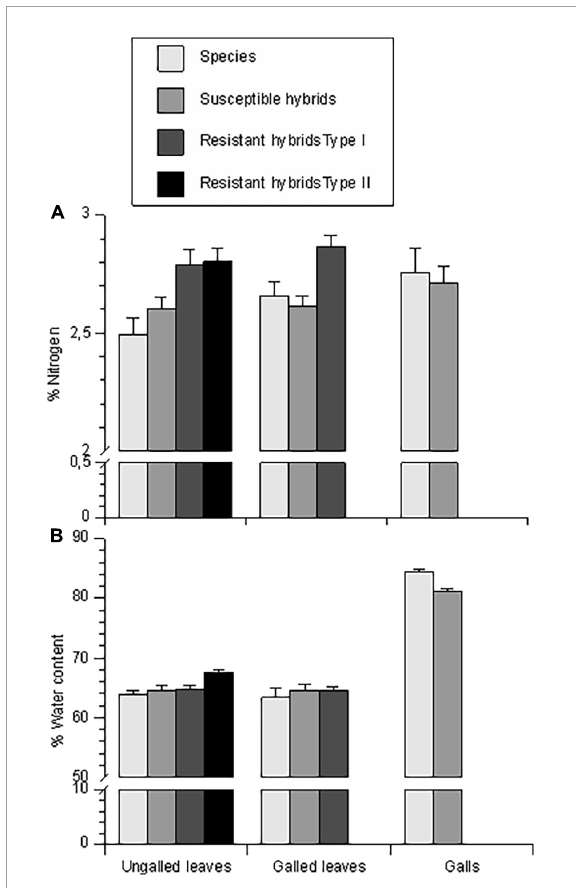
FIGURE8 Foliar concentrations of nitrogen (A) and water (B) in ungalled leaves (control leaves), galled leaves, and gall tissue of the four classes of chestnut genotypes. Bars represent means and error bars represent standard errors.